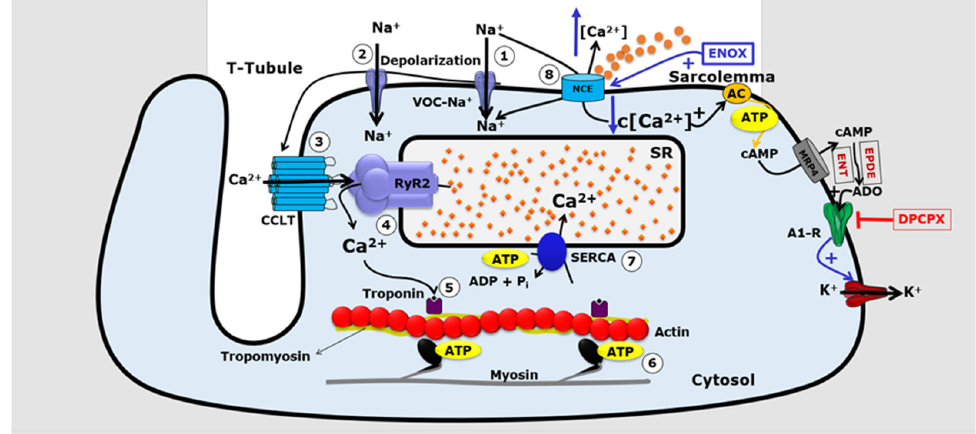
Figure 4. Molecular mechanisms involved in enoxaparin (ENOX) regulation of cardiac cell function. ENOX acts on the intracellular production and efflux of second-messenger cAMP, which is later transformed by extracellular enzymes into adenosine (ADO), which in turn is an antiarrhythmic through the activation of A1R receptors. ENOX stimulates the Na + -Ca 2+ exchanger (NCX) and, therefore, reduces cytosolic calcium in cardiac cells. In addition, ENOX is also able to block voltage-gated calcium channels, which also causes a decrease in cytosolic calcium. This reduction in cytosolic calcium in cardiomyocytes increases intracellular levels of cAMP through the activation of adenylate cyclase (AC), a membrane enzyme. cAMP activates PKA, which phosphorylates L-type Cav (L-Cav), resulting in increased Ca 2+ influx with positive chronotropic and inotropic responses. The increase in intracellular cAMP stimulates the transport of cAMP to the extracellular medium through the MRP4 ABC transporter. In the extracellular environment, cAMP is converted to ADO due to the enzymatic action of ectophosphodiesterases (EPDE) and ectonucleotidaeses (ENT). This purinergic signaling involves the action of ADO on A1R which modulates voltage-gated potassium channels in cardiac cells.